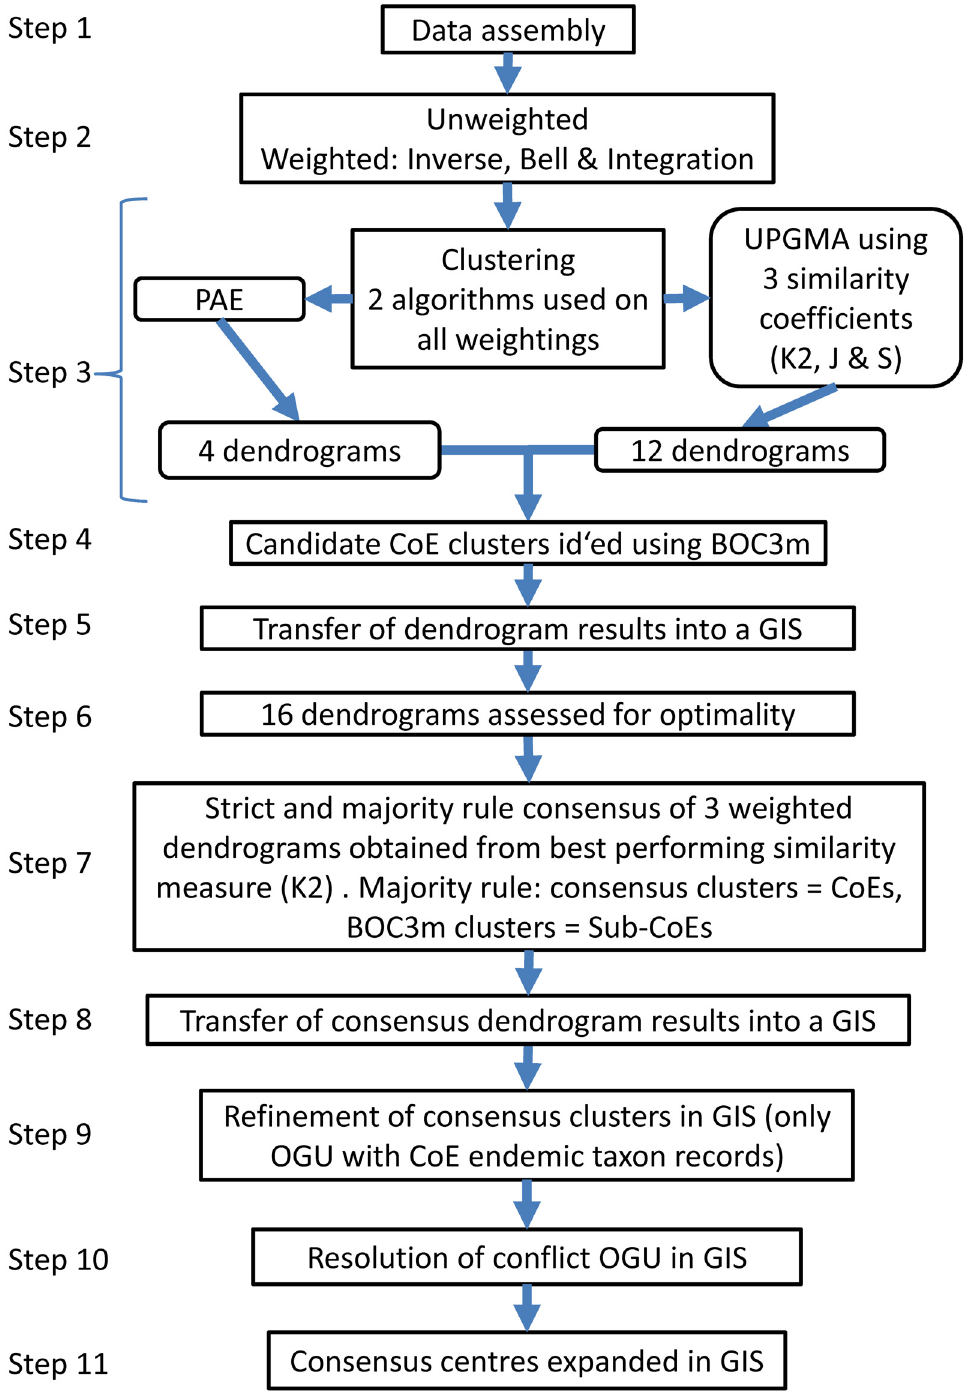
Fig 1. Flow Chart of methods. This flow chart should be read in conjunction with the methods section. [K2 = Kulczinsky2; J = Jaccard; S = Simpson; Clusters delimited using modified branch order cut-off (BOC3m; step 4 and see methods)].